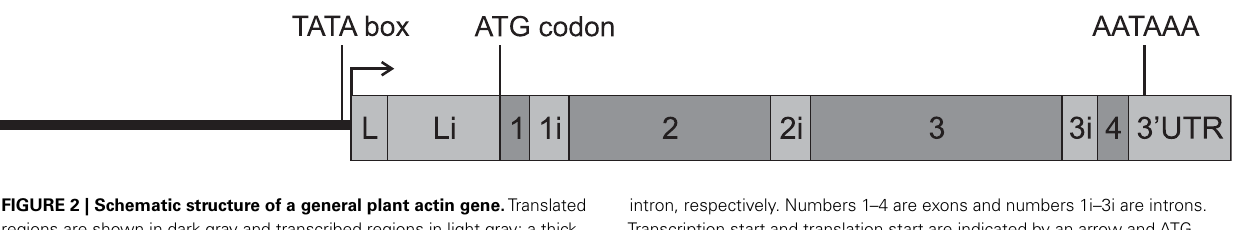
FIGURE 2 | Schematic structure of a general plant actin gene. Translated regions are shown in dark gray and transcribed regions in light gray; a thick black line indicates regulatory region. L and Li are leader exon and leader